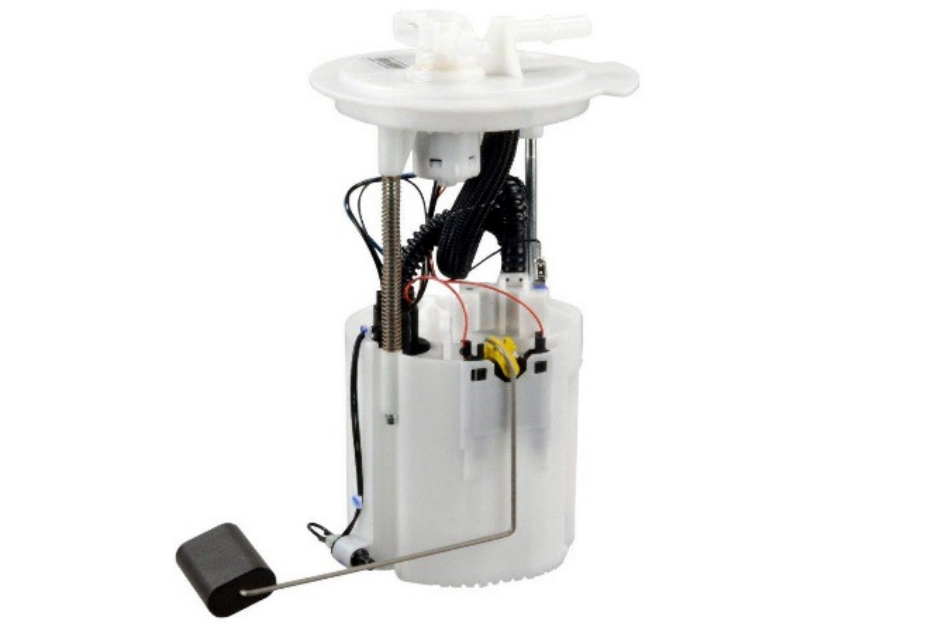
Figure 10. Plastic module of a car fuel pump with a small DC motor inside.